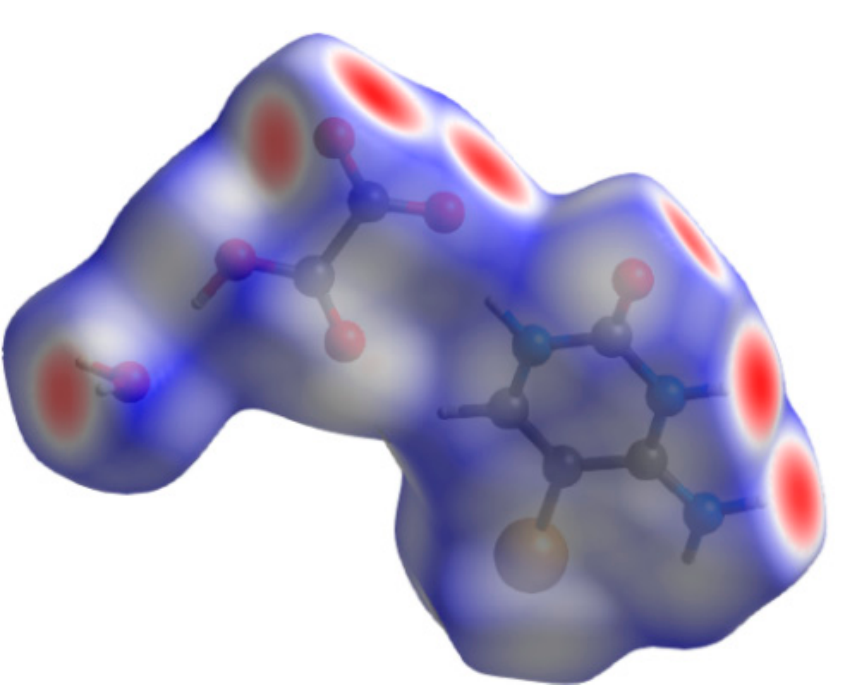
Figure 8. Visualization of the Hirshfeld surface for compound ( VI ) mapped on d norm . The color range is in arbitrary units; color scale: − 0.7300 (red) 0.9540 a.u. (blue). Figure 9 represents the relative contribution of the various atom ··· atom contacts observed for all the investigated crystal structures from the analysis of decomposed 2D- fingerprint plots (see Figures S2–S7 in the Supporting Information). In all cases, supramolec- ular arrangements are determined primarily by interatomic contacts involving oxygen and hydrogen atoms, which vary from 15.7% in compound ( I ) to 59.0% in compound ( IV ) and confirms that intermolecular neutral and charged hydrogen bonds play a fundamental role in the crystal packing. HS of compounds ( III – VI ) shows the maximum amount of O ... H/H ... O interactions compared to structures (I and II). These interactions account for 37.1–59.0% of the surface, in accordance with the presence of oxygenated anions. The H · · · H contacts, representing van der Waals interactions, comprise 7.6–16.0% of the total intermolecular contacts. The lower proportion of the Br · · · H/H · · · Br, C · · · H/H · · · C and Br · · · O/O · · · Br makes up 5.9–32.0, 3.2–9.8 and 2.0–8.9%, respectively, of the Hirshfeld surface. Lower abundances are found for N · · · H/H · · · N (0.8–7.4%), Br · · · Br (0.7–7.1%), O · · · C/C · · · O (0.5–6.9%), O · · · N/N · · · O (0.3–5.2%), Br · · · C/C · · · Br (0.9–4.6%) and Br · · · N/N · · · Br (1.2–4.6%). Cl · · · H/H · · · Cl (11.9%), C · · · Cl/Cl · · · C (8.0%), N · · · Cl/Cl · · · N (3.8%) and Br · · · Cl/Cl · · · Br (2.1%) are observed only for compound ( I ). Other intermolecular contacts contribute less than 4% to the Hirshfeld surface